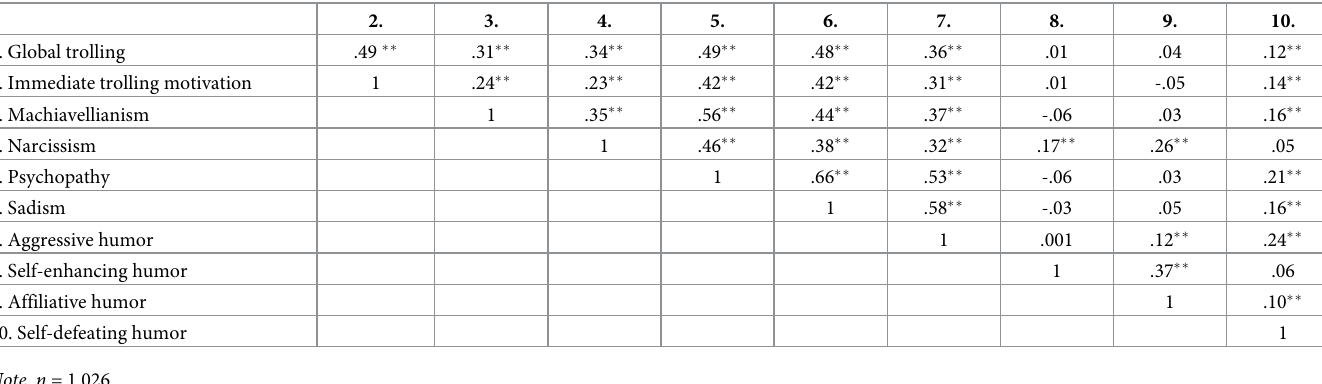
Table 3. Correlation matrix for trolling, the dark tetrad of personality, and humor